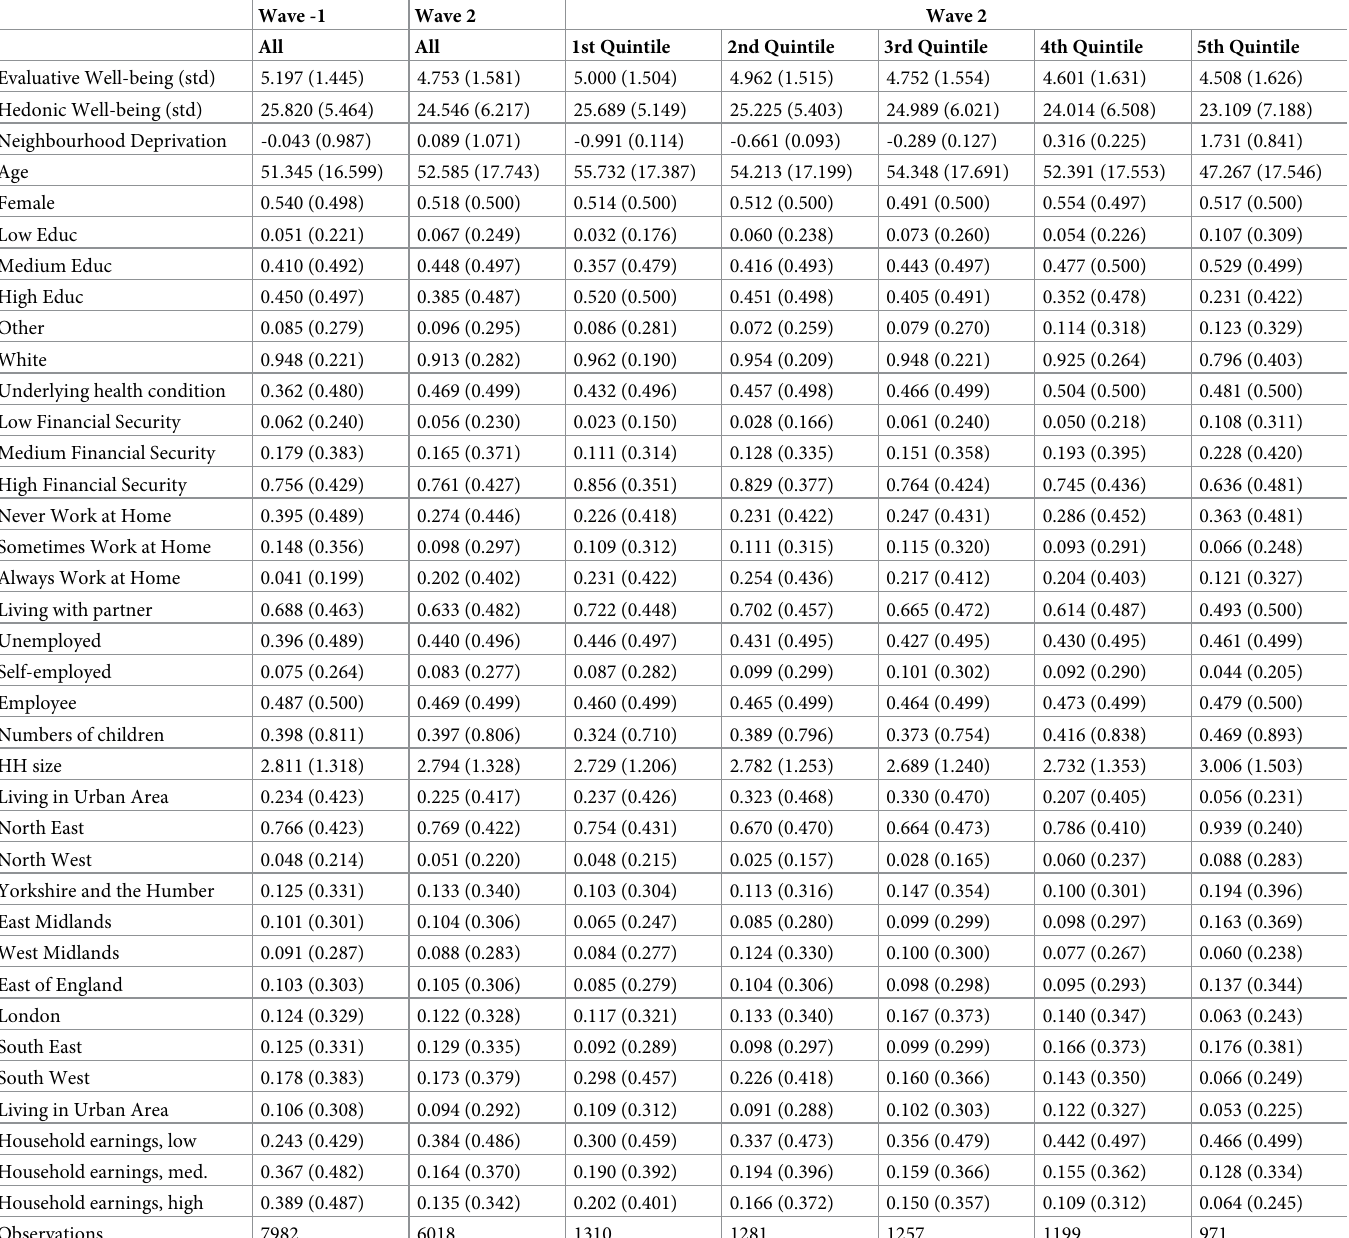
Table 1. Descriptive statistics,